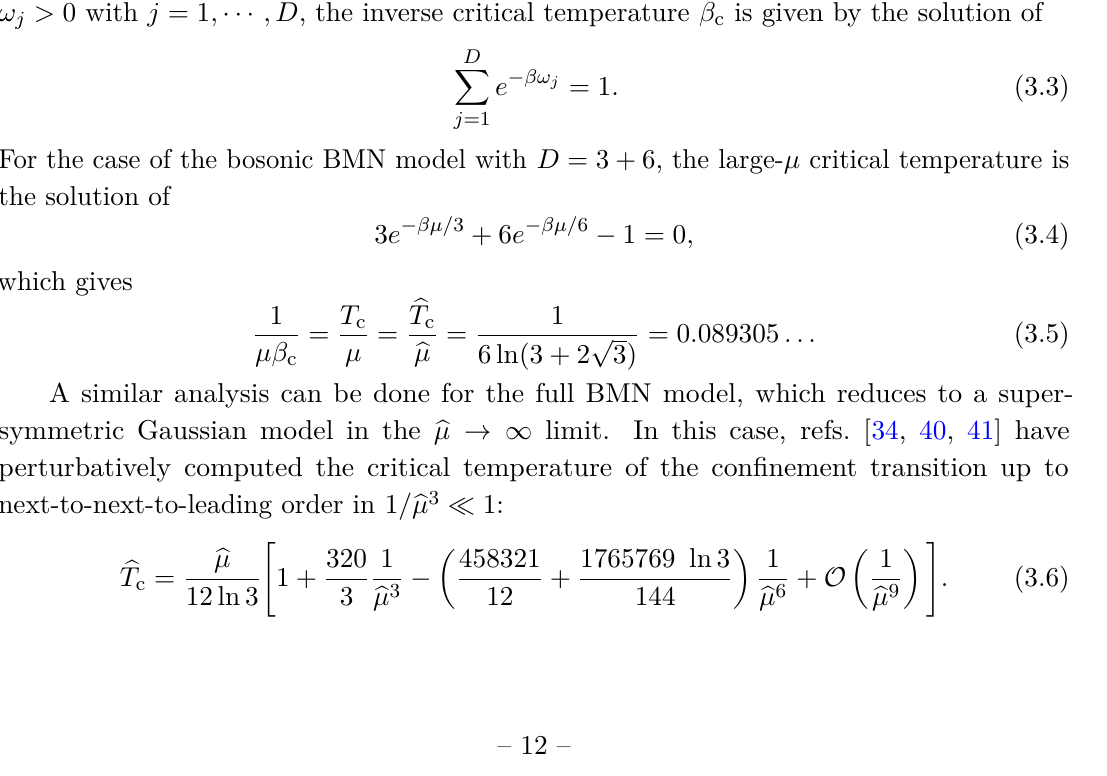
Figure 5. Angular distributions of Polyakov loop eigenvalues for considering three temperatures around the critical b T while the distribution for b T = 0 . 895 < b T